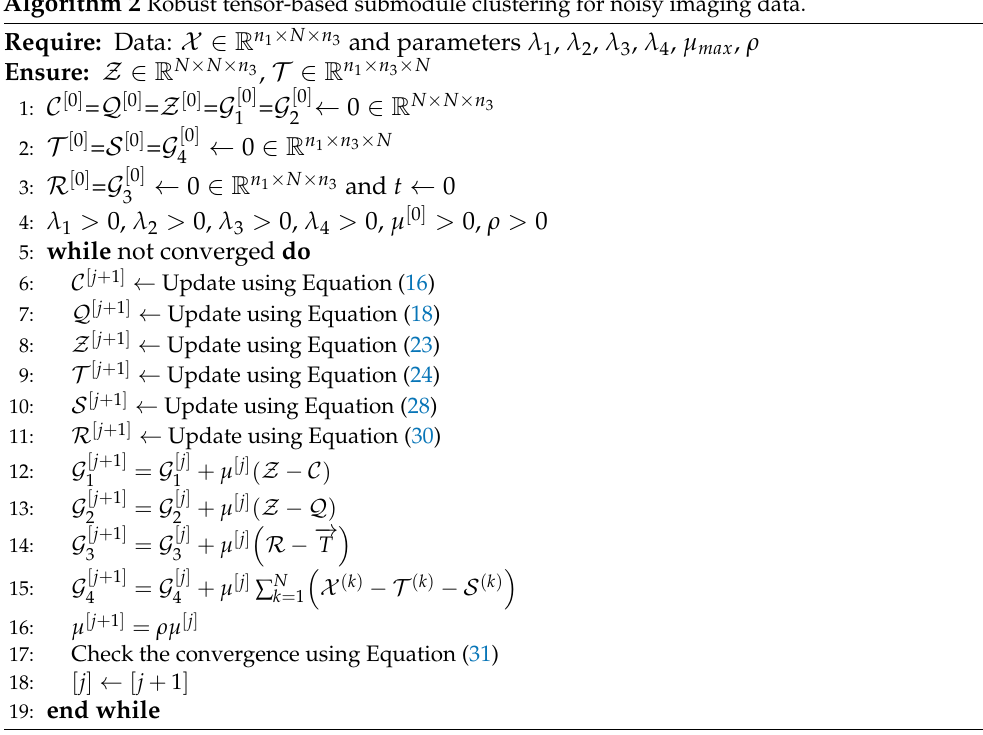
Algorithm 2 Robust tensor-based submodule clustering for noisy imaging